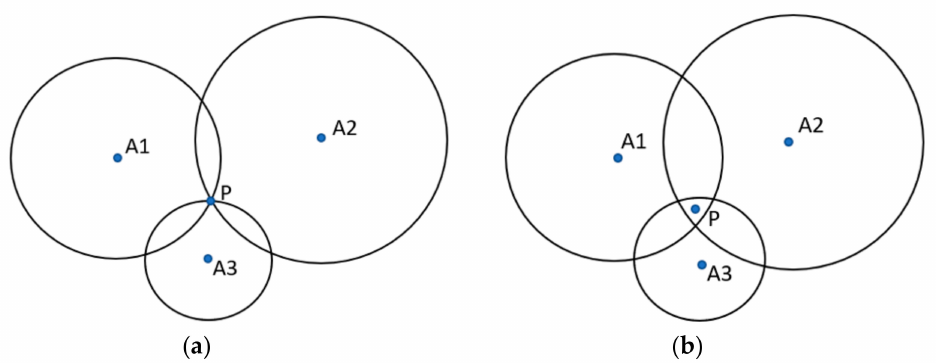
Figure 2. This diagram shows how tri-lateration can be used for localization. In diagram ( a ), the localization circles from three anchor nodes intersect at a single point P. In contrast, diagram ( b ) illustrates how distance errors result in the circles not intersecting at a single point meaning a least square fitting method is required for position